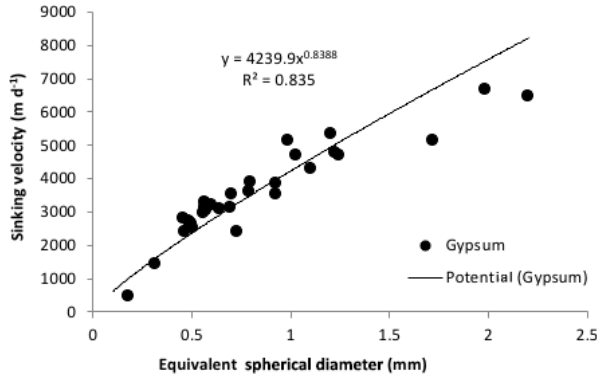
Figure 7. Sinking velocity of cryogenic gypsum crystals plotted against equivalent spherical diameter